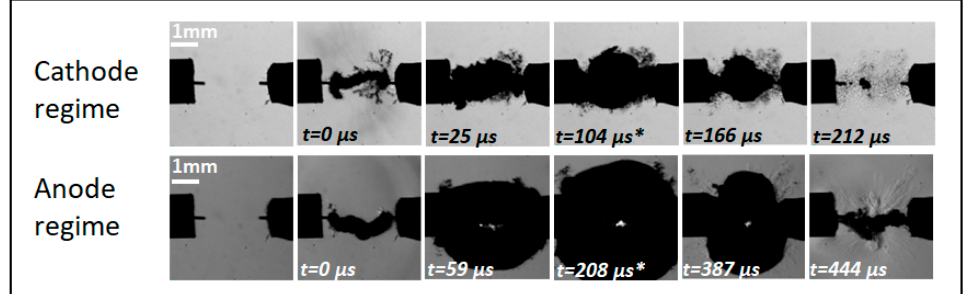
Figure 6. Time evolution of the bubbles obtained after breakdown in cathode and anode regimes (* indicates the maximum radius)—t = 0 µs corresponds to the breakdown (12 kV–100 µS/cm). The corresponding videos are provided as supplementary material.